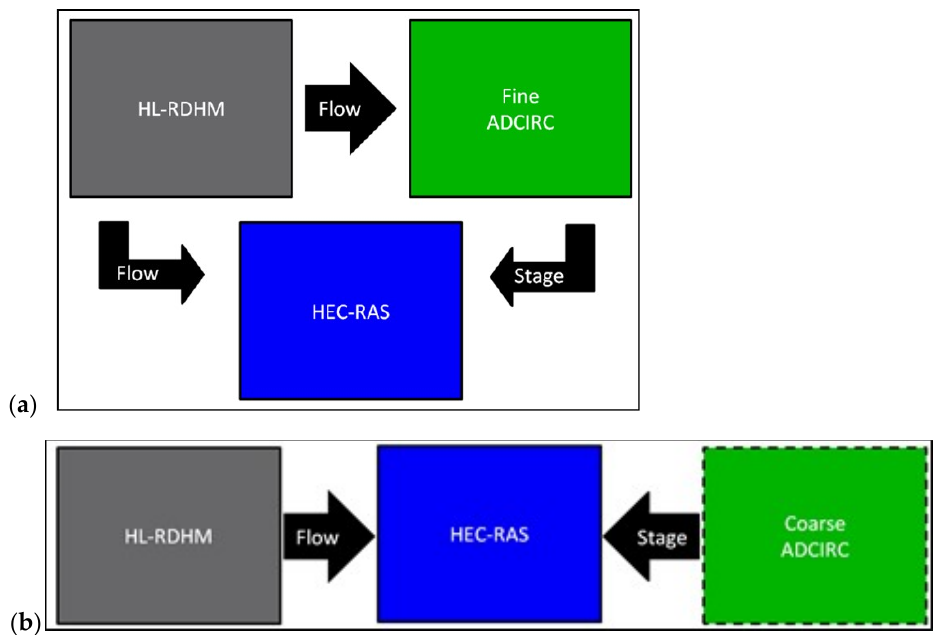
Figure 3 . Coupling scheme 2: HEC-RAS middleware using ( a ) fine or ( b ) coarse ADCIRC.